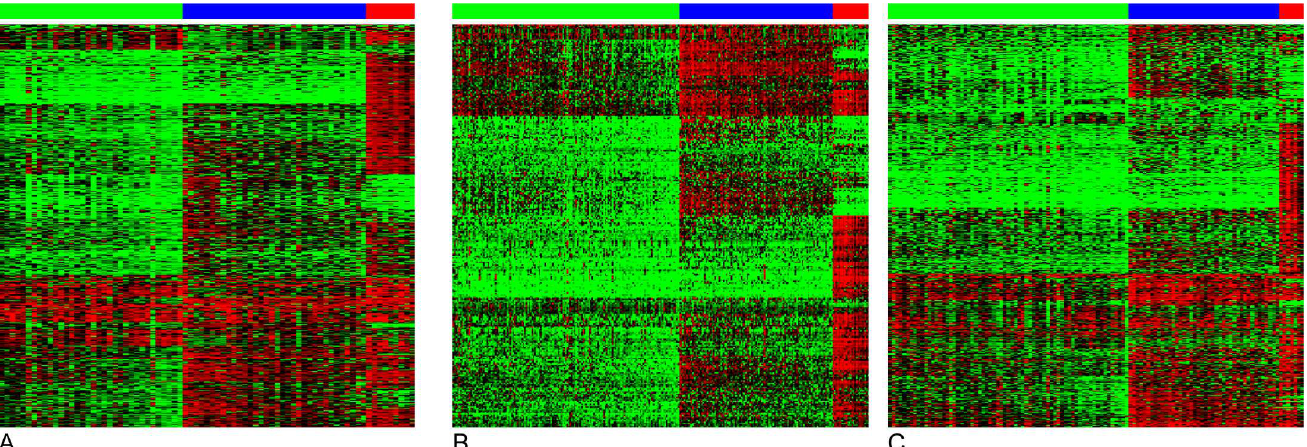
Fig 1. Consensus clustering reveals three distinct tumor subgroups. Consensus clusteringof the 8000 most variable methylation-probesin the pilot dataset identifiedthree subgroups of tumors with low (green bar), intermediate (blue bar), and high levels of DNA methylation (gCIMP, red bar). The average β -value for each tumor and CpG probe range from 0 (absence of methylation, green in heatmap) to 1 (complete methylation, red in heatmap). Consensus clustering was performed separatelyin (A) 77 glioma tumors analyzedon the 450k methylation array, (B) 285 TCGA glioblastomatumors analyzedon the 27k methylation array and (C) 116 TCGA glioblastomatumors analyzedon the 450 k methylation array.